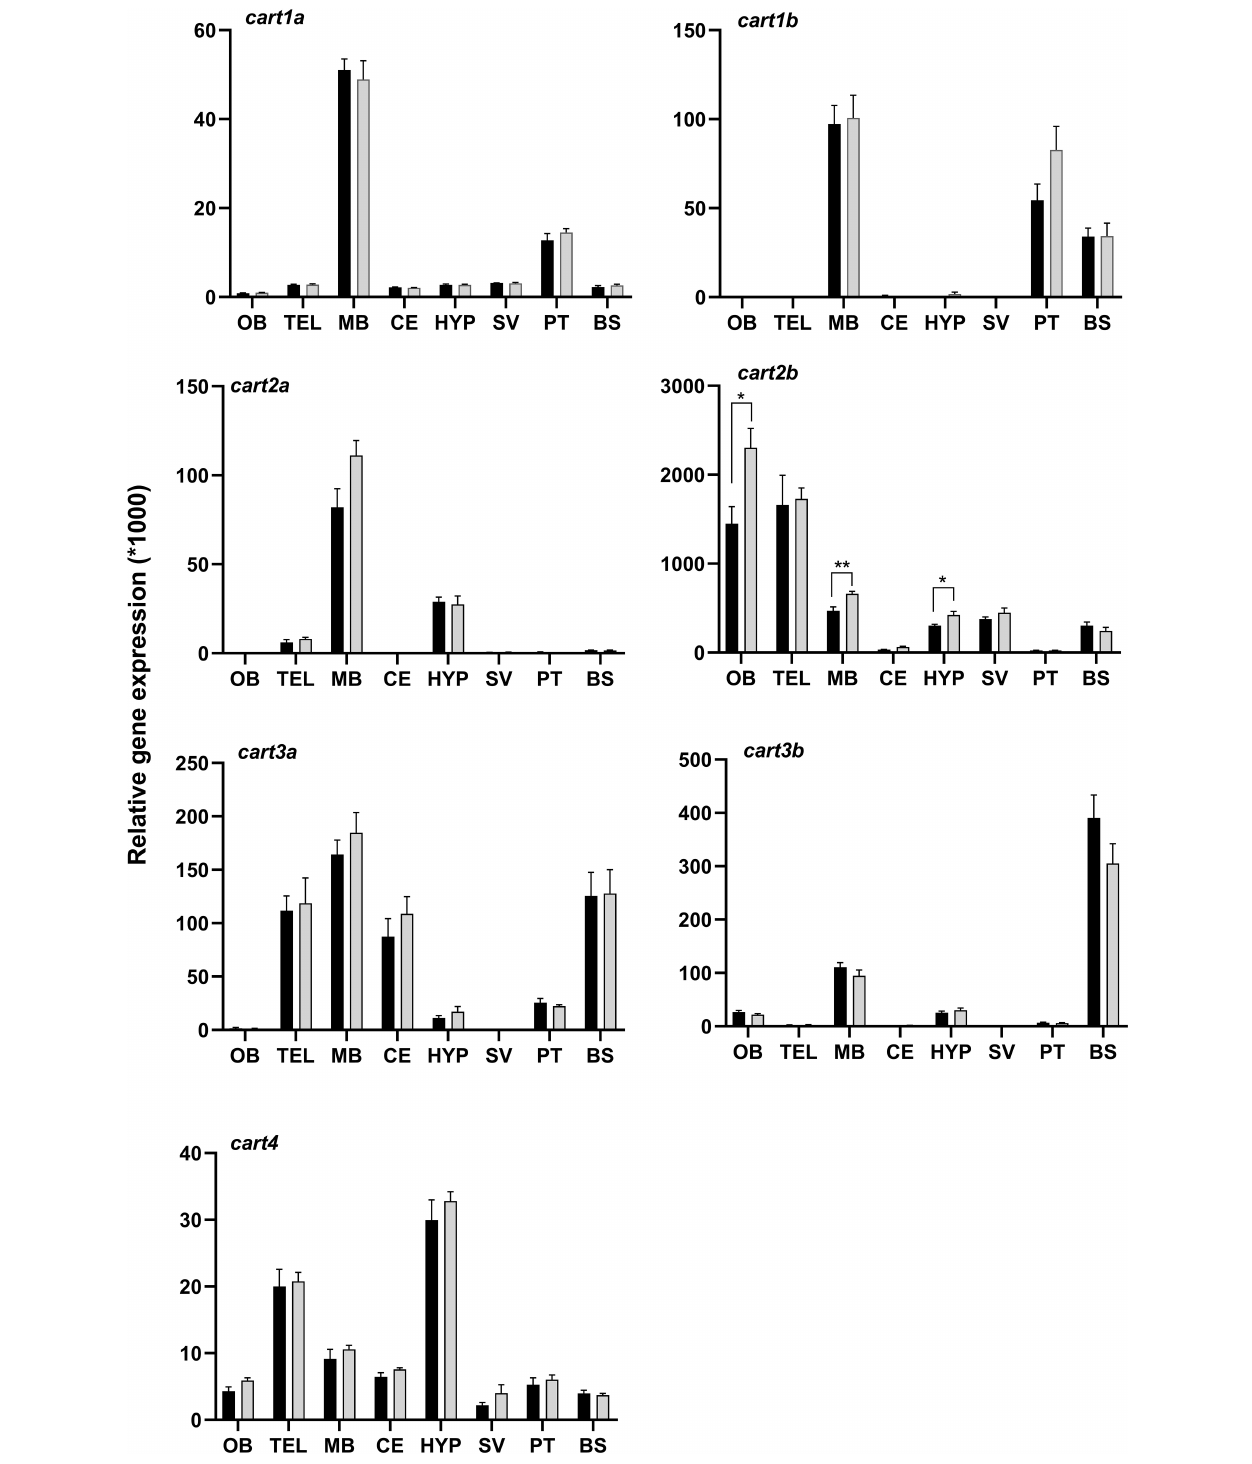
FIGURE 4 | Effect of 4 days of fasting on the mRNA expression of cart paralogs in eight brain regions of Atlantic salmon. Black and gray bars represent fed ( n = 6 except for SV n = 4) and fasted ( n = 6 except for SV n = 4) groups, respectively. The graphs show the normalized cart mRNA copy number to the geometric mean copy number of actin beta and s20 . Two-tailed t -test and non-parametric Mann-Whitney test was performed to assess the statistically significant differences between the two groups. The error bars represent mean ± SEM and asterisks show the significant level (* p < 0.05, ** p < 0.01). OB, olfactory bulb; TEL, telencephalon; MB, midbrain; HYP, hypothalamus; CE, cerebellum; SV, saccus vasculosus; PT, pituitary; BS, brain stem.